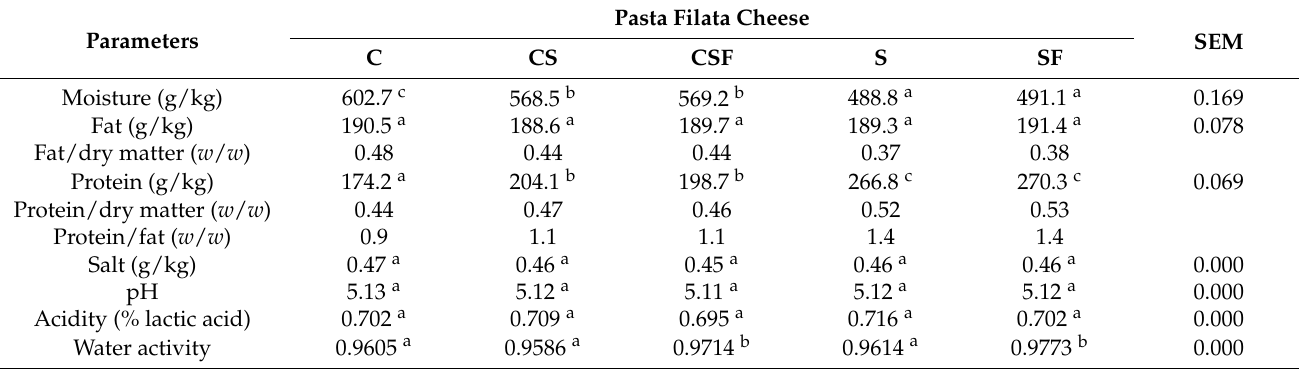
Table 2. Composition and physicochemical properties of pasta filata cheeses from frozen cow’s and sheep’s